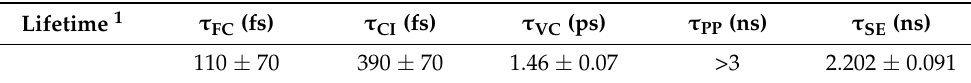
Table 1. Lifetimes and associated errors extracted from the global fit of the usujirene/palythene aqueous solution TAS.